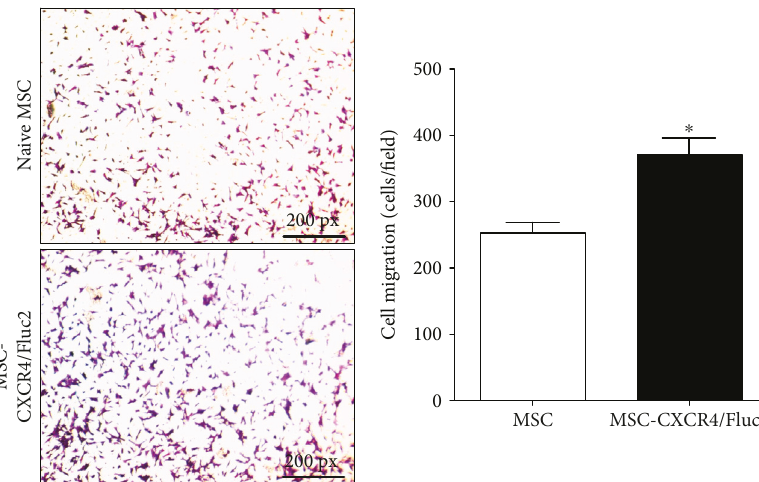
Figure 4: Chemotaxis assay for MSC-CXCR4/Fluc2. MSCs and MSC-CXCR4/Fluc2 in serum-free medium were placed into the upper well of a 24-well Transwell plate, and 0.5% FBS was added to the lower well. The plates were incubated for 6 h, and then cells that migrated into the lower well were fi xed, stained with crystal violet, and photographed in 4x magni fi cation. One representative experiment of three is